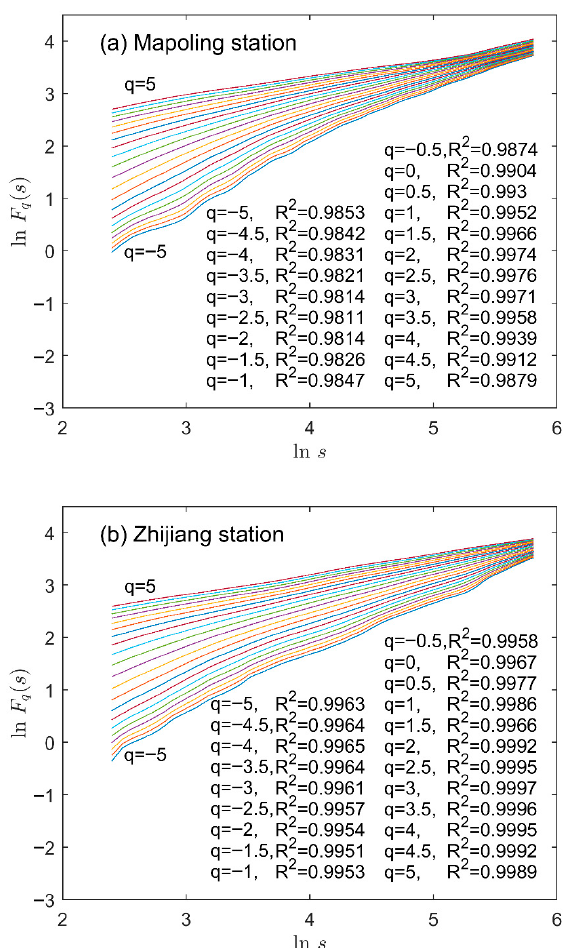
Figure 5. The log–log plots of q th fluctuation function 𝐹 (cid:3044) (𝑠) versus time scale s of the daily precipitation time series data, removing the periodicity at the ( a ) Mapoling and ( b ) Zhijiang stations.